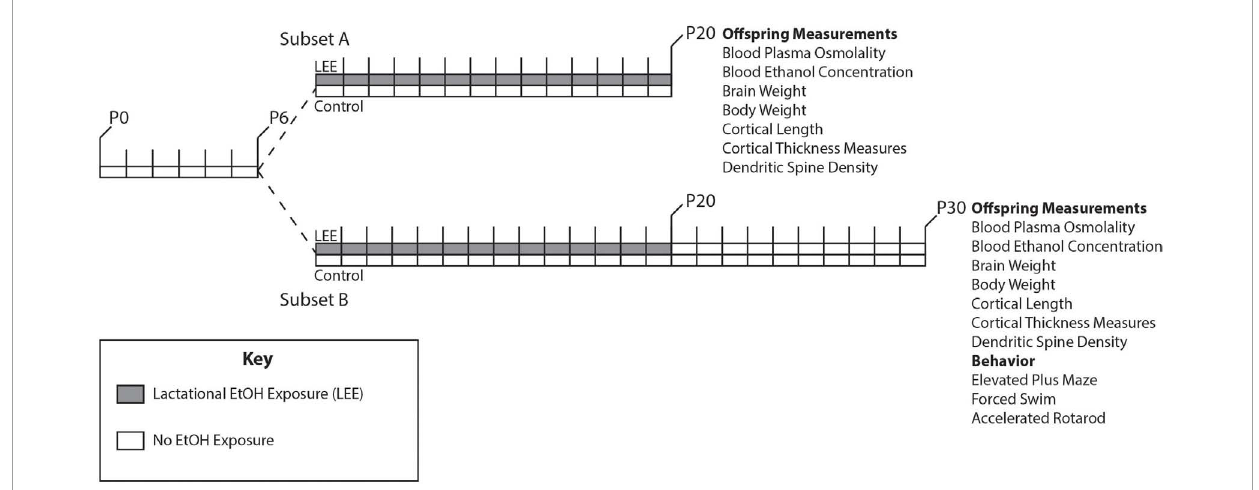
FIGURE1 Experimental paradigm. Mice were designated as control or LEE at P6. LEE dams received 25% EtOH when pups were P6-P20. At P20 pups were weaned, divided into two subsets, and no longer exposed to EtOH. Subset A was subjected to a variety of measurements at P20. Subset B was subjected to measurements as well as behavioral tests at